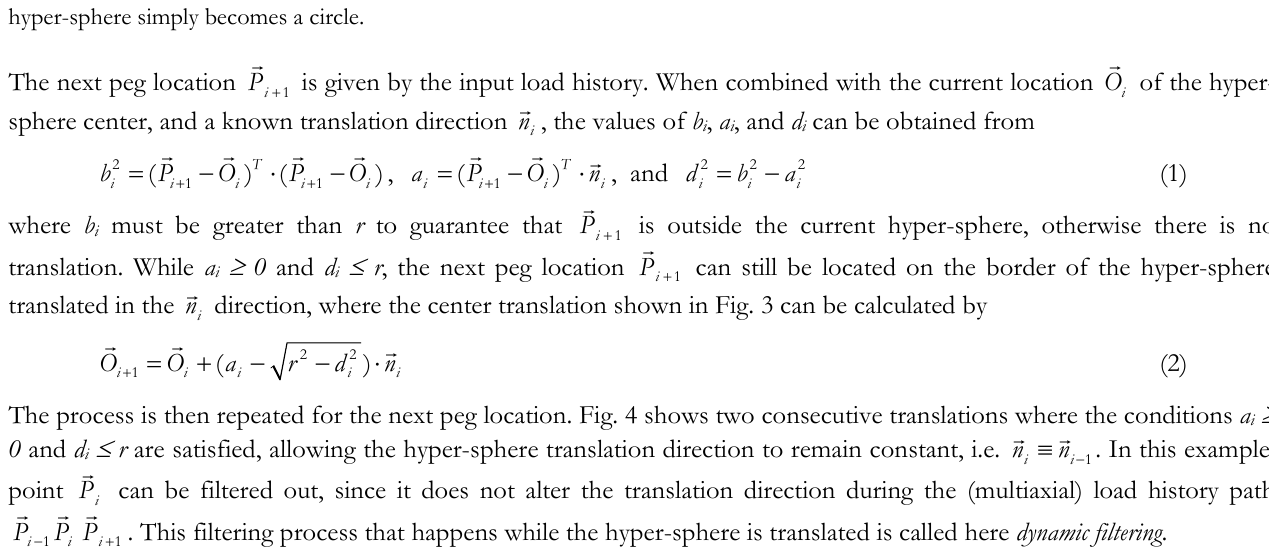
  P P to . For this 2D tension-torsion example, the  i 1 i